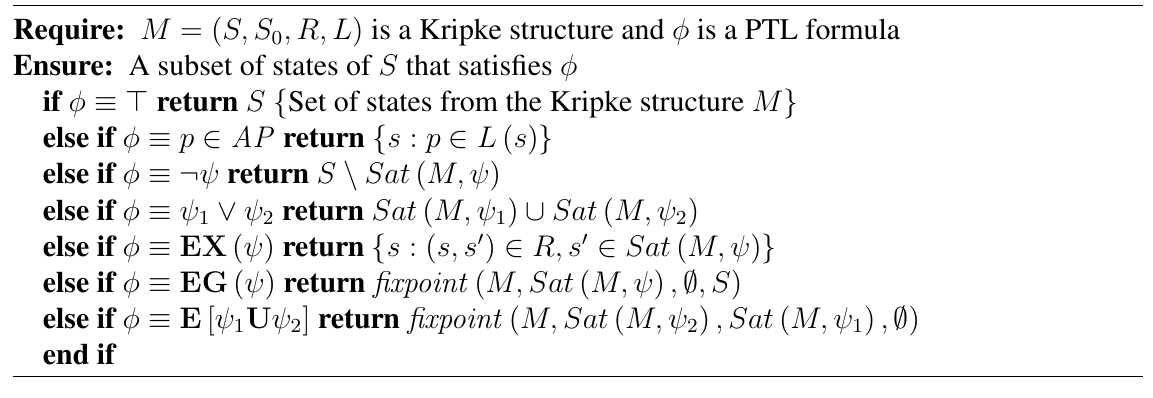
Algorithm 1 Algorithm Sat ( M, φ )